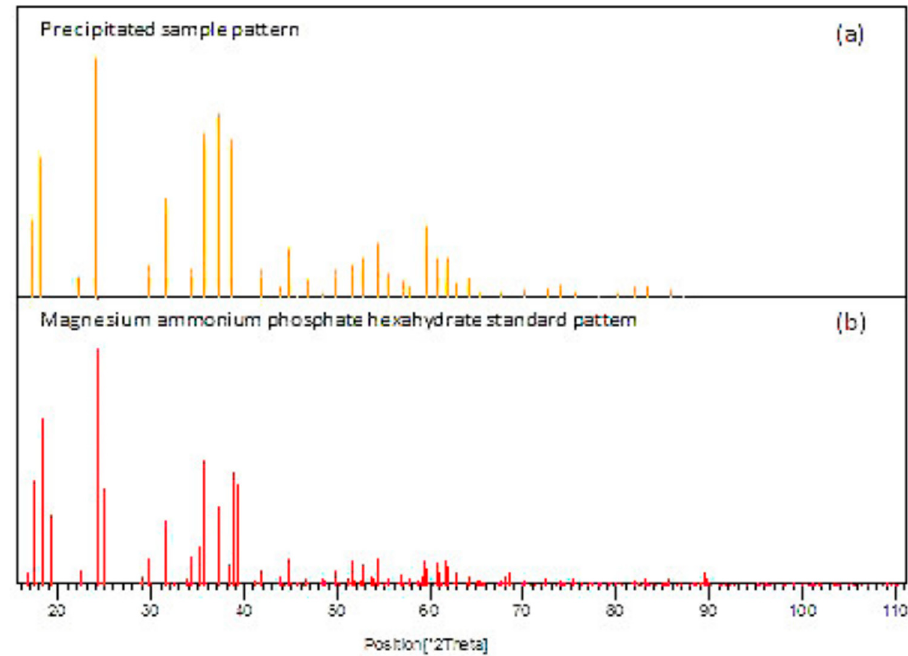
Figure 2. XRD patterns of precipitates in the cathode chamber, ( a ) precipitated sample; and ( b ) magnesium ammonium phosphate standard.